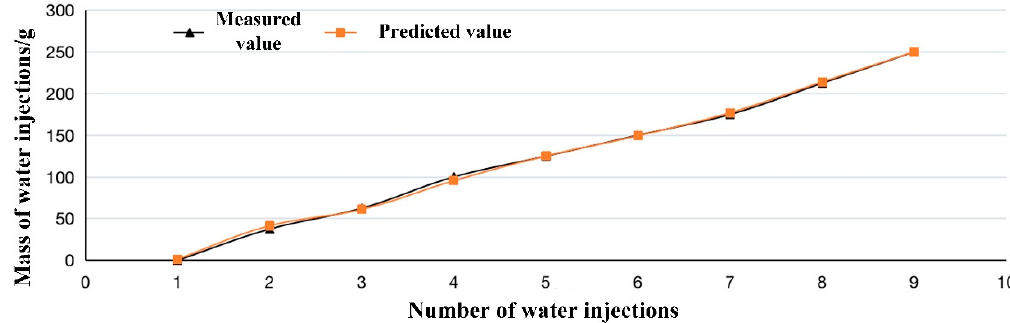
Figure 8. Prediction performance of LSTM model.